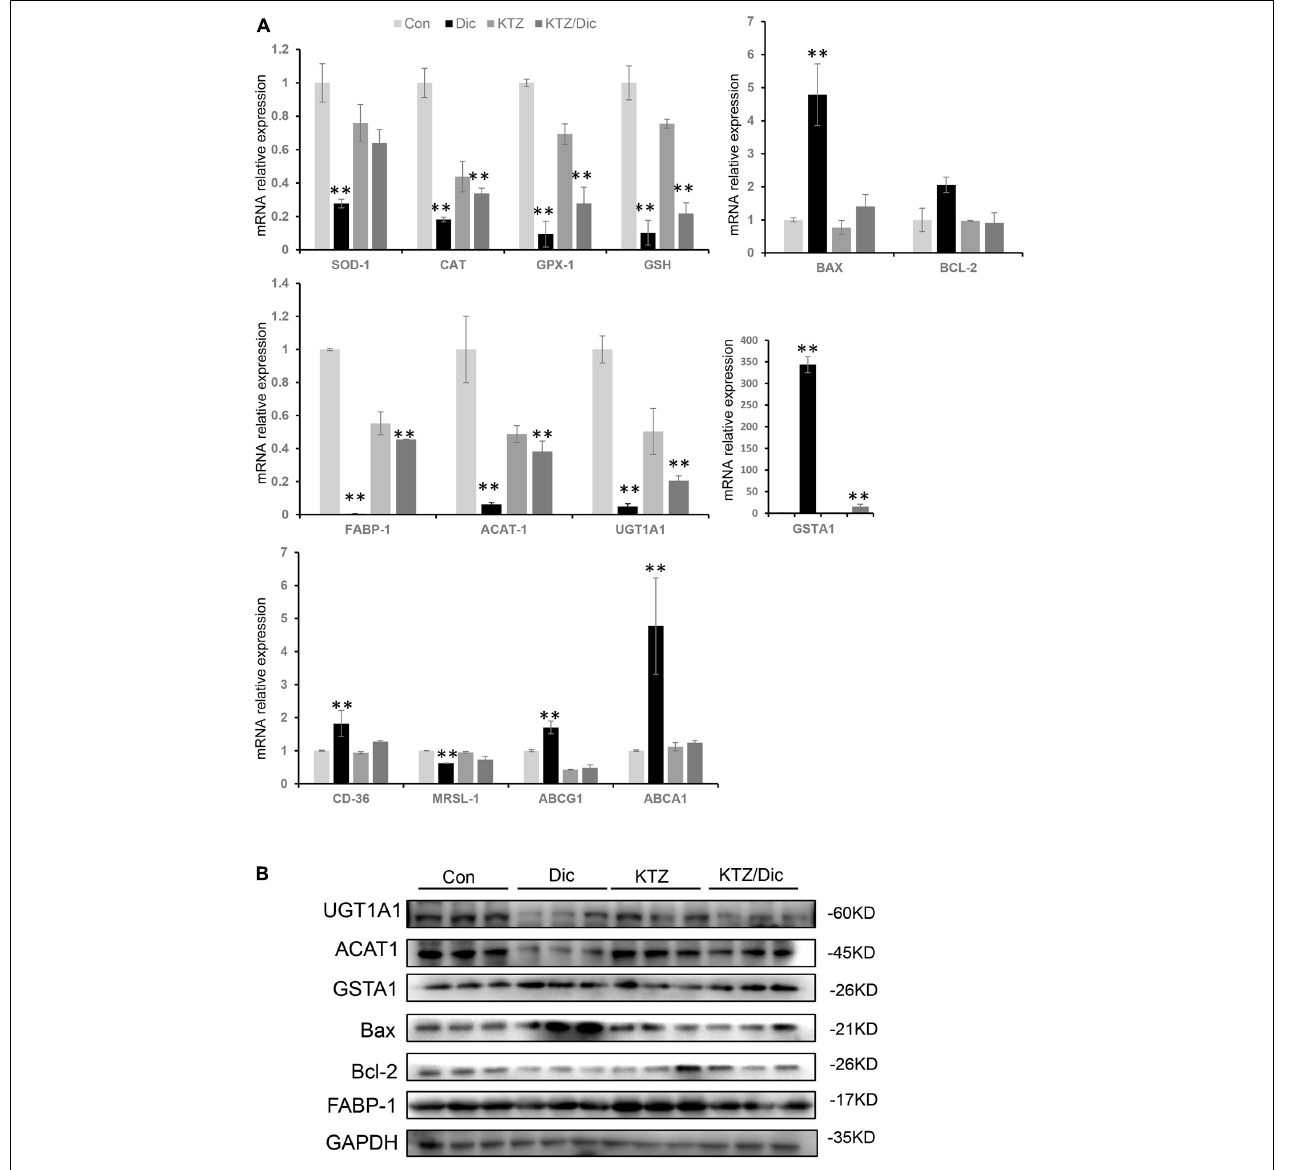
FIGURE 5 | Validation of differentially expressed genes at mRNA and protein levels. (A) qRT-PCR analysis of the relative expression of mRNA and protein - related genes. Expression level presented as means ± SD ( n = 3), ∗∗ P < 0.01, vs. Con. (B) Western blot analysis of UGT1A1, ACAT1, and GSTA1, Bax, Bcl-2 and FABP-1 protein levels. Densitometric analysis shows protein levels relative to